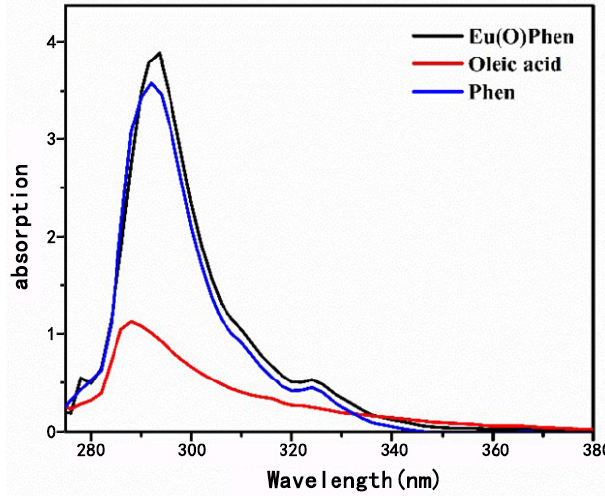
3+ Phen complex, oleic acid, and Phen.